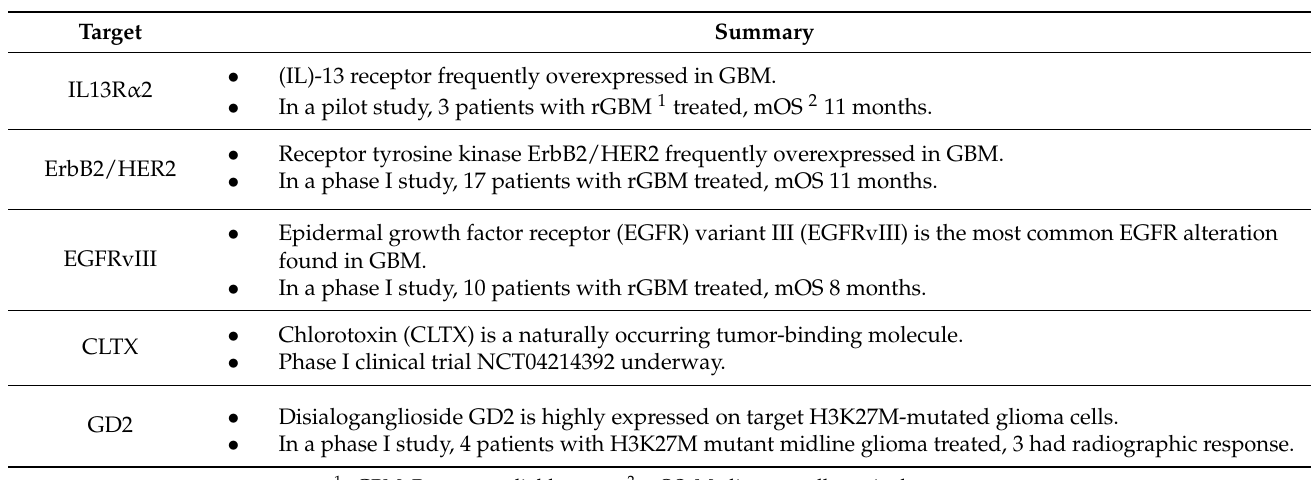
Table 2. Chimeric Antigen Receptor (CAR) T-Cell Therapies in Glioma.